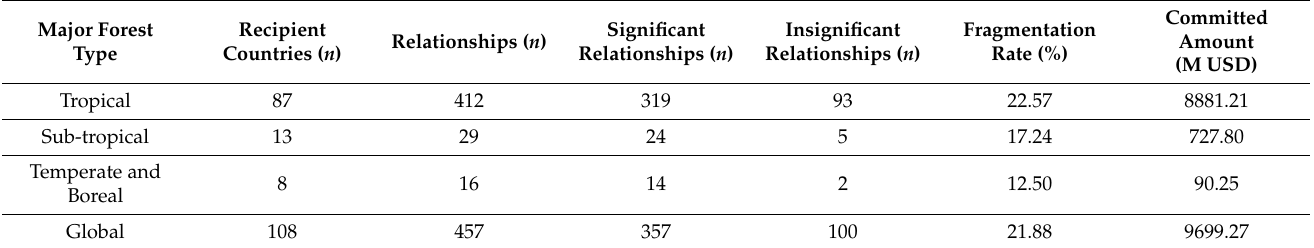
Table 4. Fragmentation of REDD+ finance.